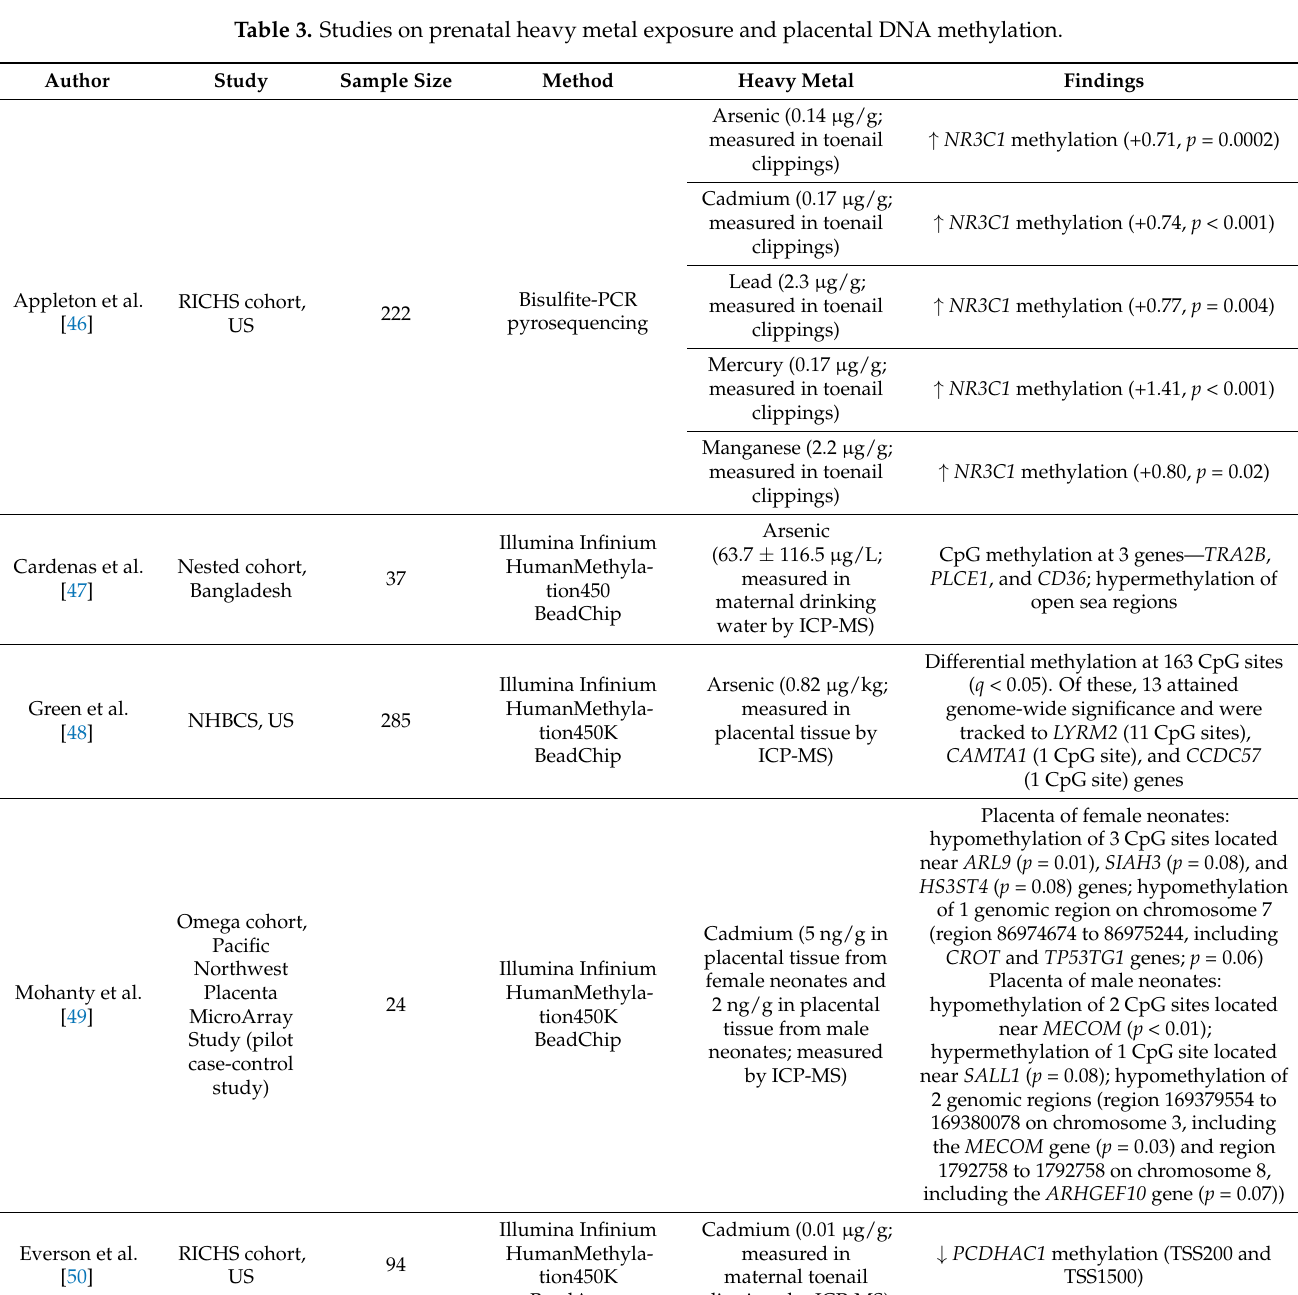
Table 3. Studies on prenatal heavy metal exposure and placental DNA